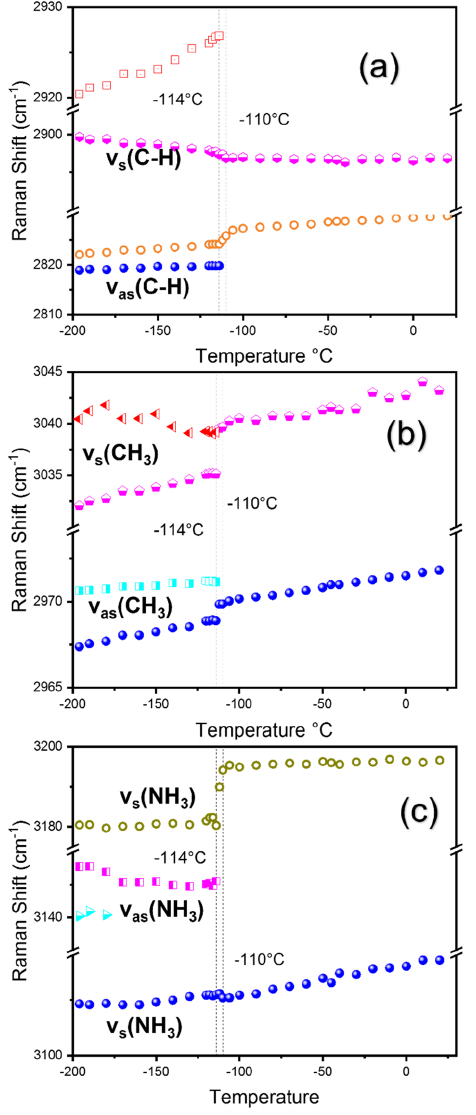
Figure 8. (Color online) Temperature dependences of the Raman shift in a 2700–3400 cm − 1 frequency range ( a – c ). Phase boundaries are shown as vertical dotted lines along with the phase transition temperatures.